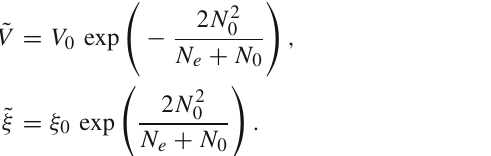
Fig. 1 The inflationary parameter n s as a function of N 0 for different numbers of e-foldings during inflation: N e = 55 (blue solid curve), N e = 60 (red dash curve) and N e = 65 (green dash-dot curve)